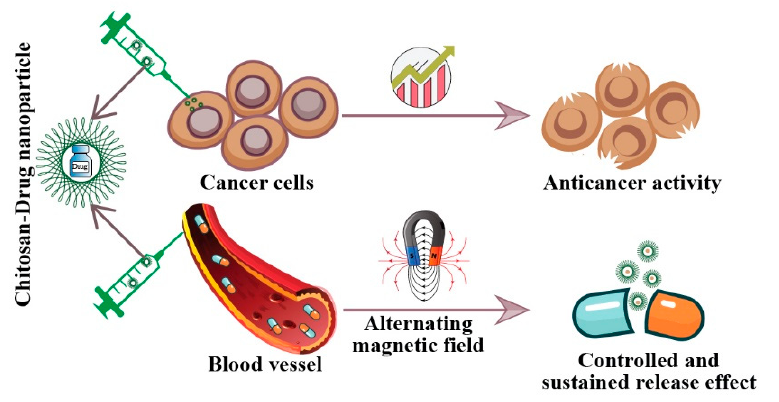
Figure 4. Co-delivery of chemotherapeutic drugs using chitosan-based nanocarriers. Chitosan-based drug delivery systems improve the TI of chemotherapeutic drugs through a controlled and sustained release effect. Chitosan-drug nanocarriers also reduce the therapeutic concentration of approved chemotherapeutic drugs, thereby minimize the toxic effects on healthy cells. This diagram reflects potential outcomes, and does not indicate any experimental findings. Therapeutic index: